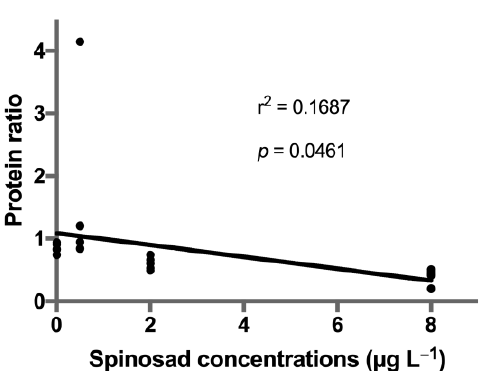
Figure 2. Linear regression of the ratios of identified globins expression in Chironomus riparius after exposure to spinosad. p value indicates deviations from zero slope.